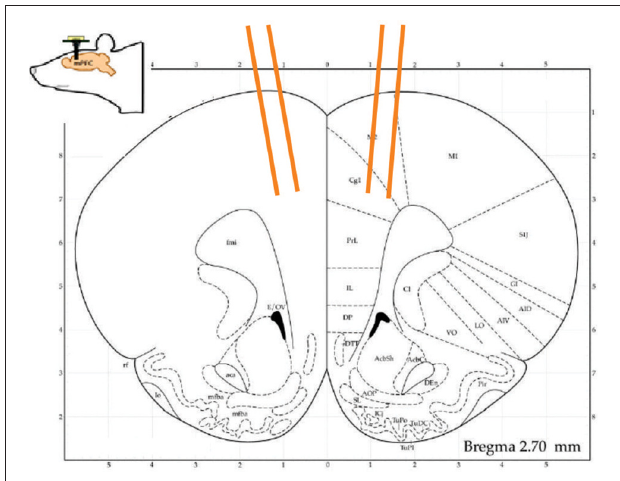
FIGURE 2 | A schematic of the presumed tetrode tracts at 2.7 mm